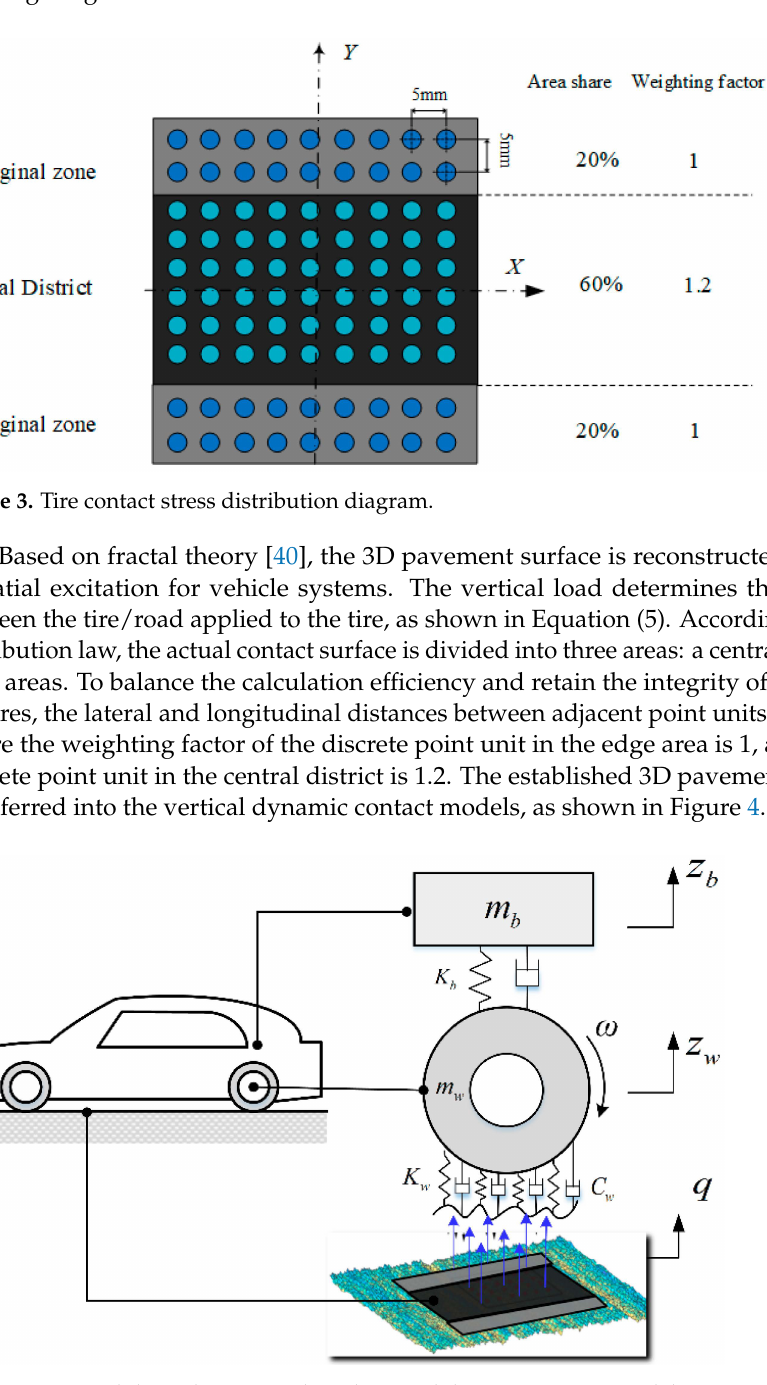
Figure 4. Tire and three-dimensional road vertical dynamic contact